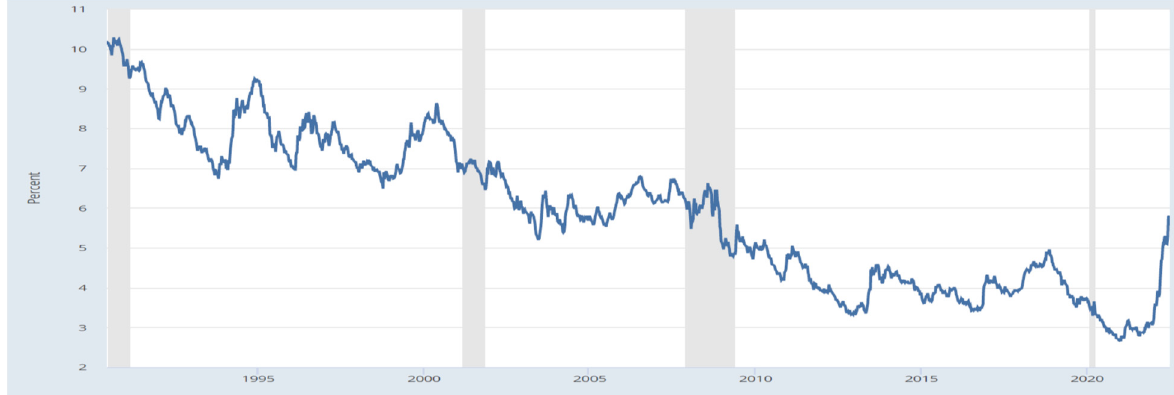
Figure 19. 30 Year Average Fixed Mortgage Rate. Source: Freddie